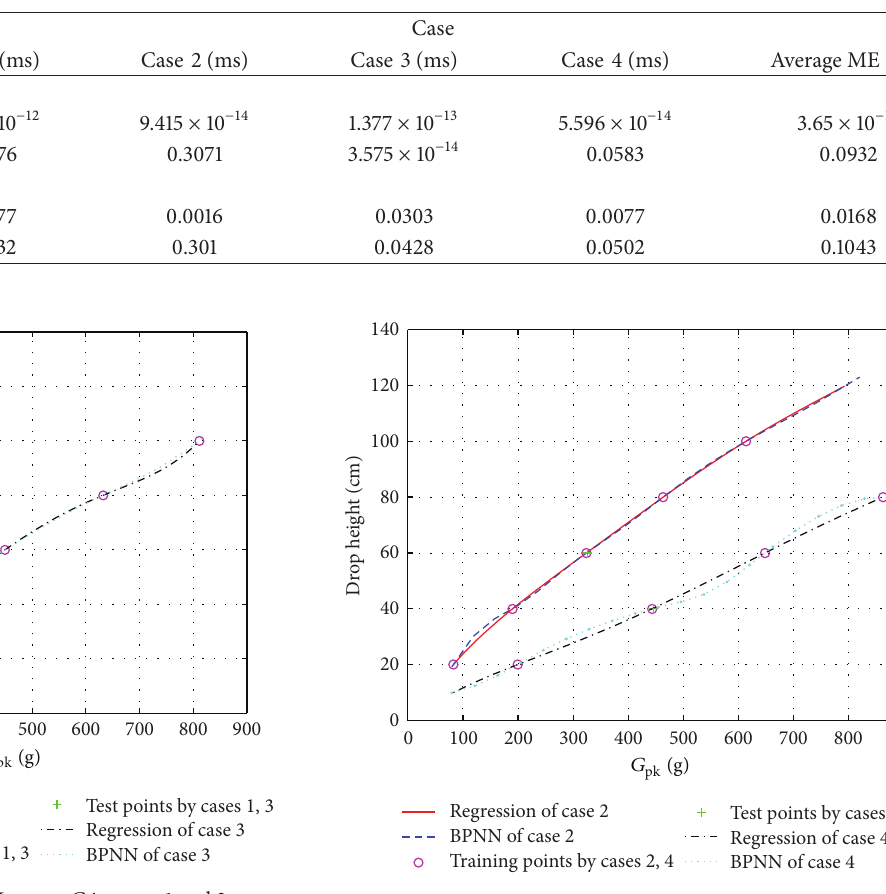
Figure 9: Fitting curves of 𝐻 versus 𝐺 in cases 1 and 3. Figure 10: Fitting curves of 𝐻 versus 𝐺 in cases 2 and